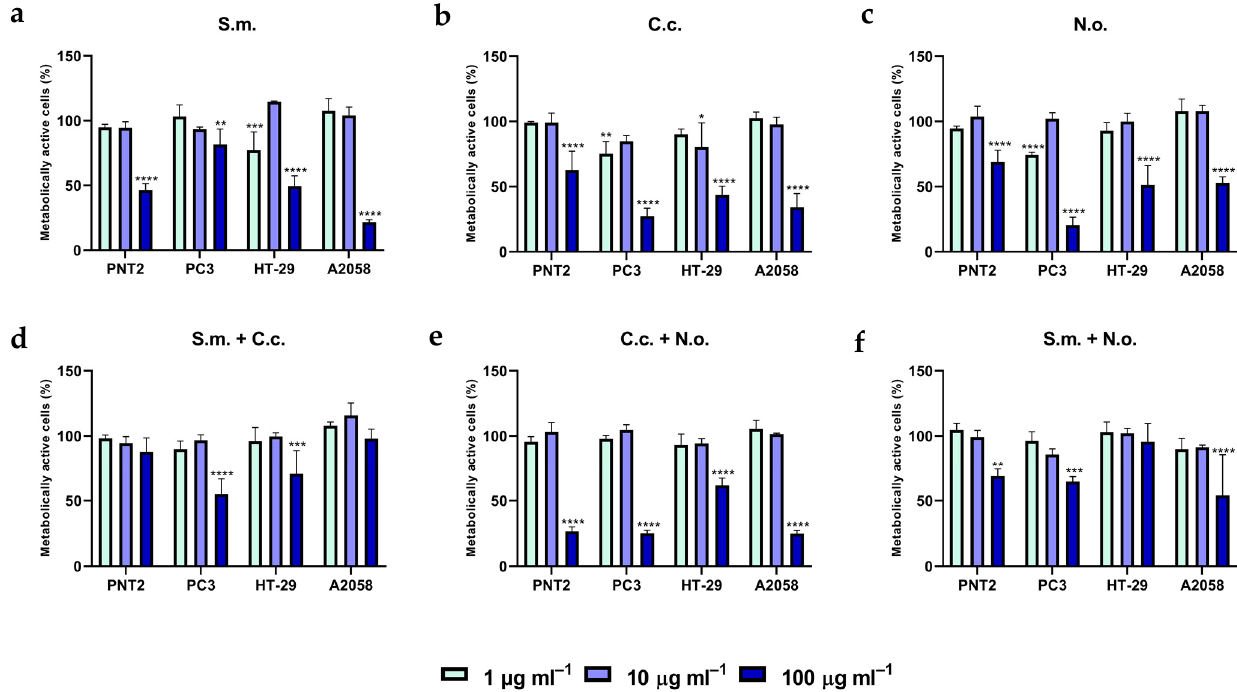
Figure 3. Percentage of viable human cells treated during 48 h with 1, 10 or 100 µg mL − 1 of algal extract from mono and co-cultivation. Panels ( a – c ) represent results obtained by MTT assay on the PNT2, PC3, HT29 and A2058 cell lines treated with extracts from mono-cultivation. Panels ( d – f ) represent results obtained by MTT assay on the PNT2, PC3, HT29 and A2058 cell lines treated with extracts from co-cultivation. Statistical significance is calculated through Dunnett test and is indicated by **** ( p ≤ 0.0001), *** ( p ≤ 0.0005), ** ( p ≤ 0.005) and * ( p ≤ 0.05). S.m. = Skeletonema marinoi , C.c. = Cyclotella cryptica , N.o. = Nannochloropsis oceanica , S.m.+ C.c. = co-cultivation of C.c. and S.m., C.c. + N.o. = co-cultivation of C.c. and N.o., S.m. + N.o. = co-cultivation of S.m. and N.o. Values are expressed as mean ± SD.